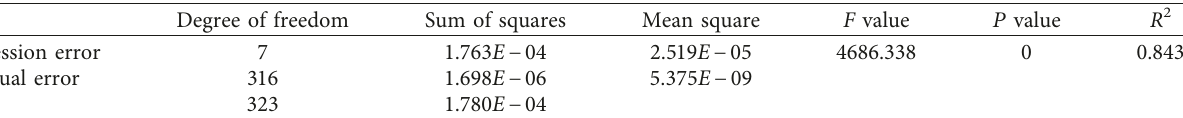
Table 6: Fitting results of the filed data with the modified chloride diffusion model.